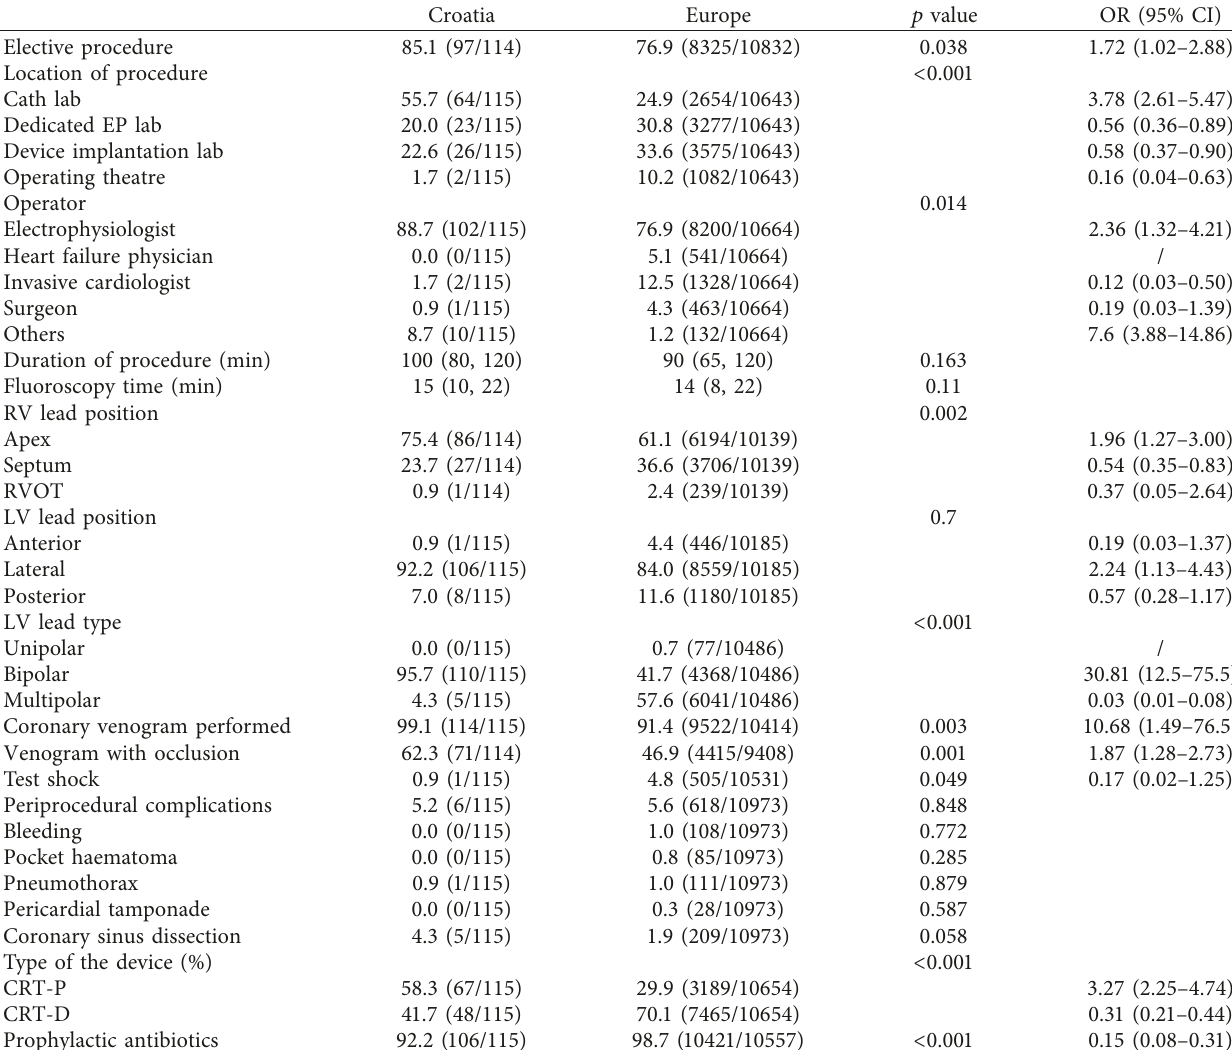
Table 2: Procedural data of Croatian CRT population and comparison with the European